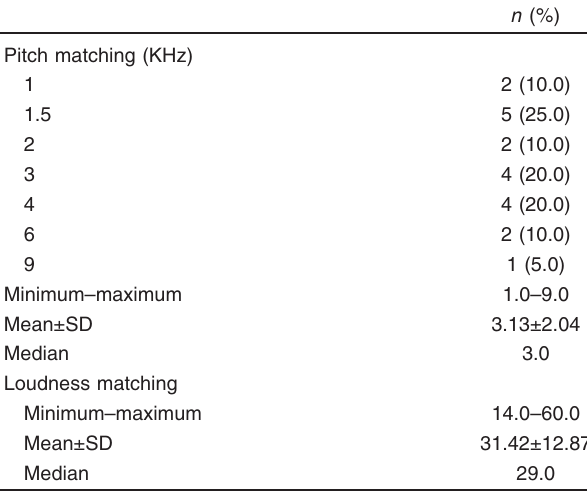
Table 10 Distribution of the studied cases according to pitch matching and loudness matching ( n =